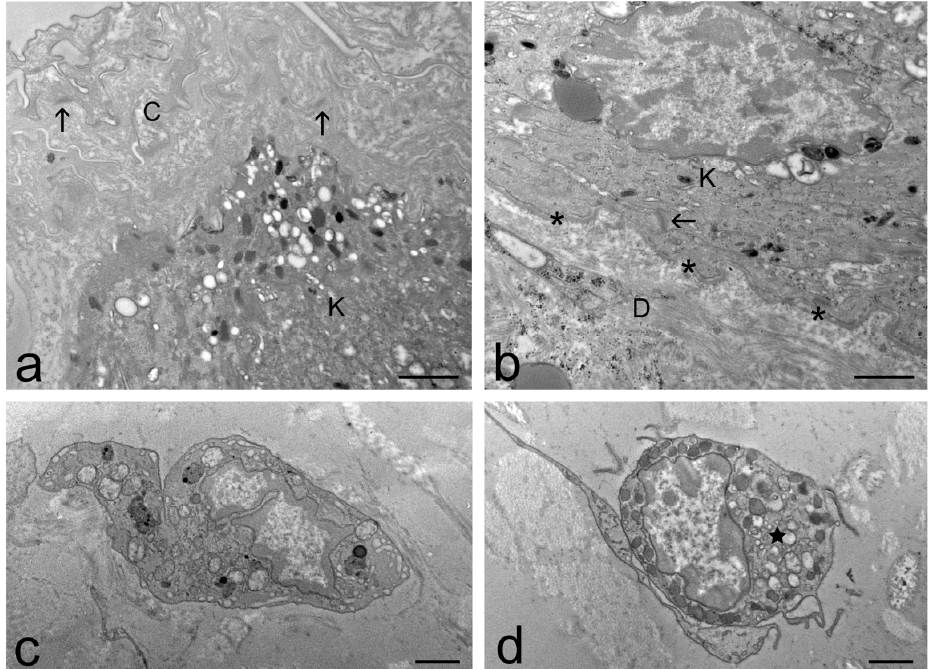
Figure 15. TEM micrographs of human skin explants treated with substance P and maintained in the bioreactor for 72 h. The epidermis ( a ) is preserved both in the upper layer ( a ) and in the basal layer ( b ), although some vacuolization is present in keratinocytes (K). Note the well-preserved intercellular junctions between corneocytes (arrows in ( a )) and keratinocytes (K) (arrow in ( b )) as well as the basal membrane (asterisks in ( b )). ( c ) A macrophage contains many vacuoles. ( d ) A mast cell shows partial degranulation (star). D, dermis. Bars: 1 µ m.